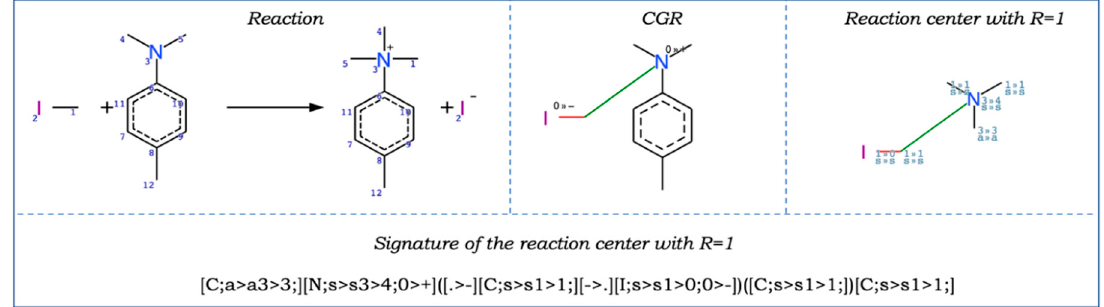
Figure 1. A chemical reaction (top left), its Condensed Graph of Reaction (CGR) (top centre), and the reaction centre with R = 1 (top right). Colour lines on CGR represent dynamic bonds. Indices “0 >> − ” and “0 >> +” on CGR mean that atomic charges are lowered from 0 to − 1 and increased from 0 to +1, respectively. Indices “1 >> 0” and 1 >> 1” on the reaction center mean changes in the number of neighbors, letters—hybridization changes (“s”—sp 3 , “a”—atom is in the aromatic ring). The signature of the reaction center with R = 1 is shown.